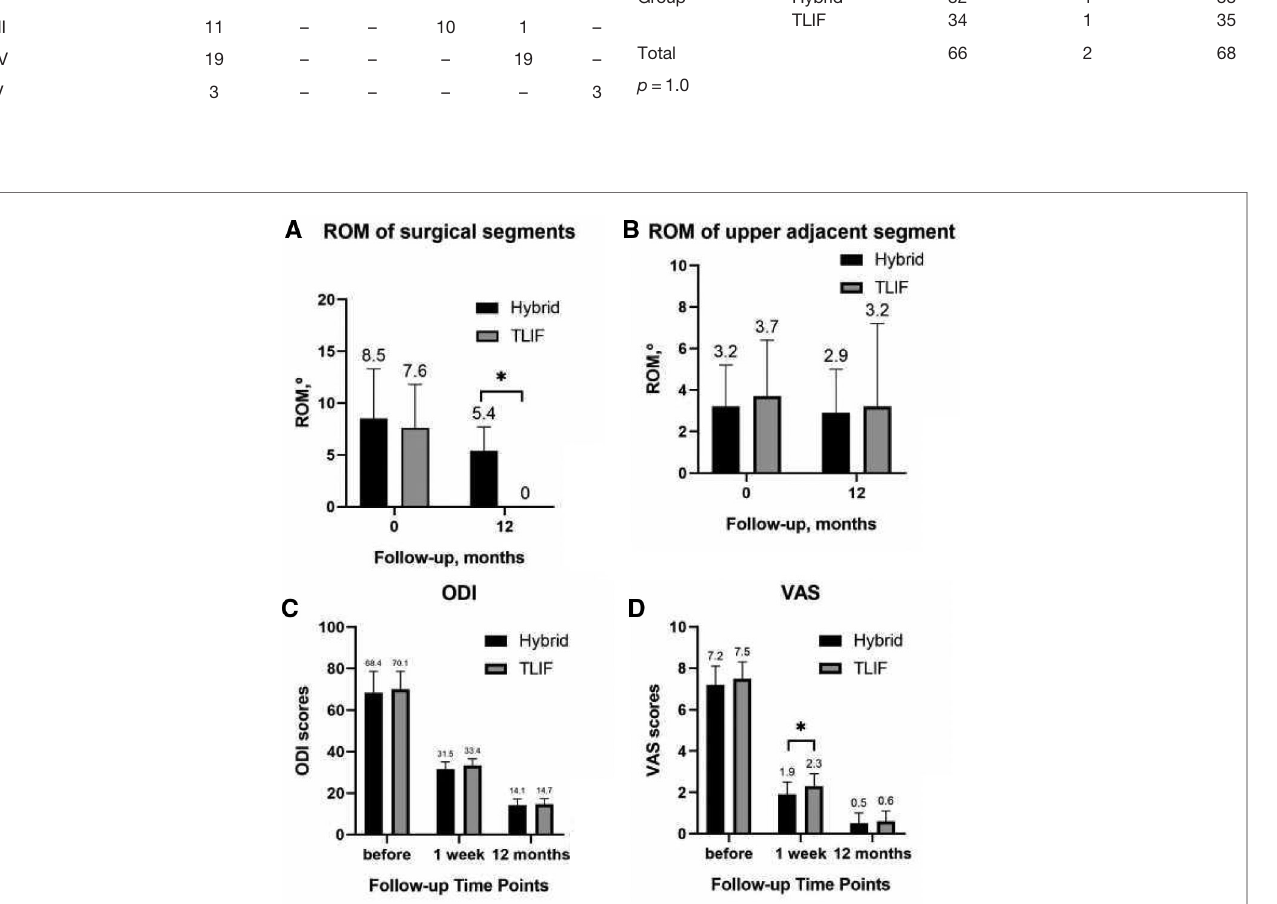
TABLE 7 | Degeneration rate.